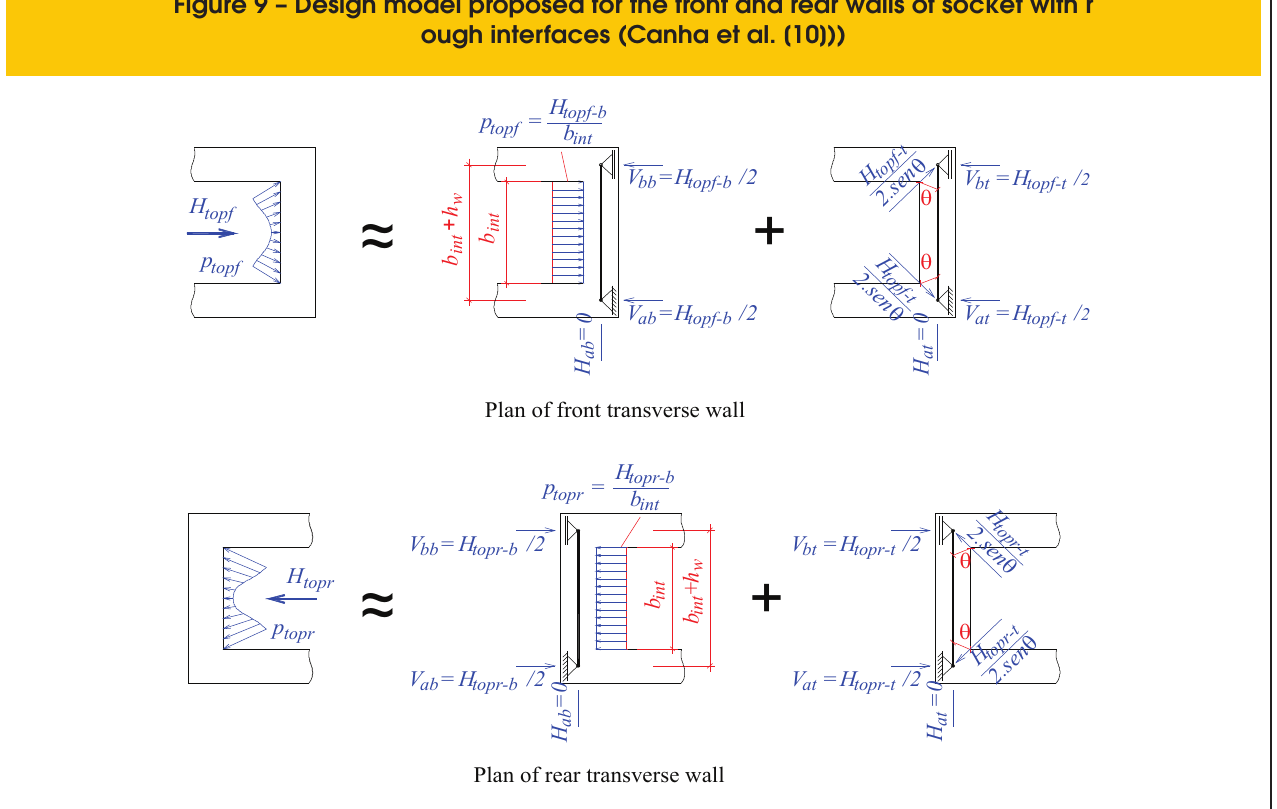
Figure 9 – Design model proposed for the front and rear walls of socket with